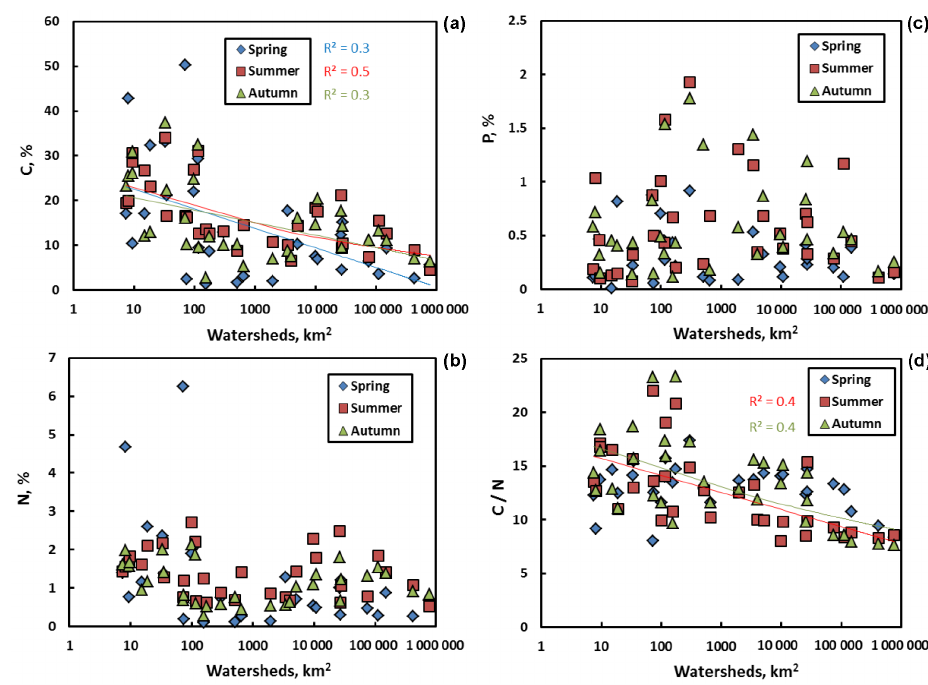
Figure 2. Particulate ( > 0 . 45µm) C (a) , N (b) and P (c) concentrations in the RSM (%), and C : N ratio (d) in RSM as a function of river watershed size. The solid lines represent a power-law fitting of the data with regression coefficients shown for each season in corresponding panels. Only the curves with R 2 > 0 . 3 are